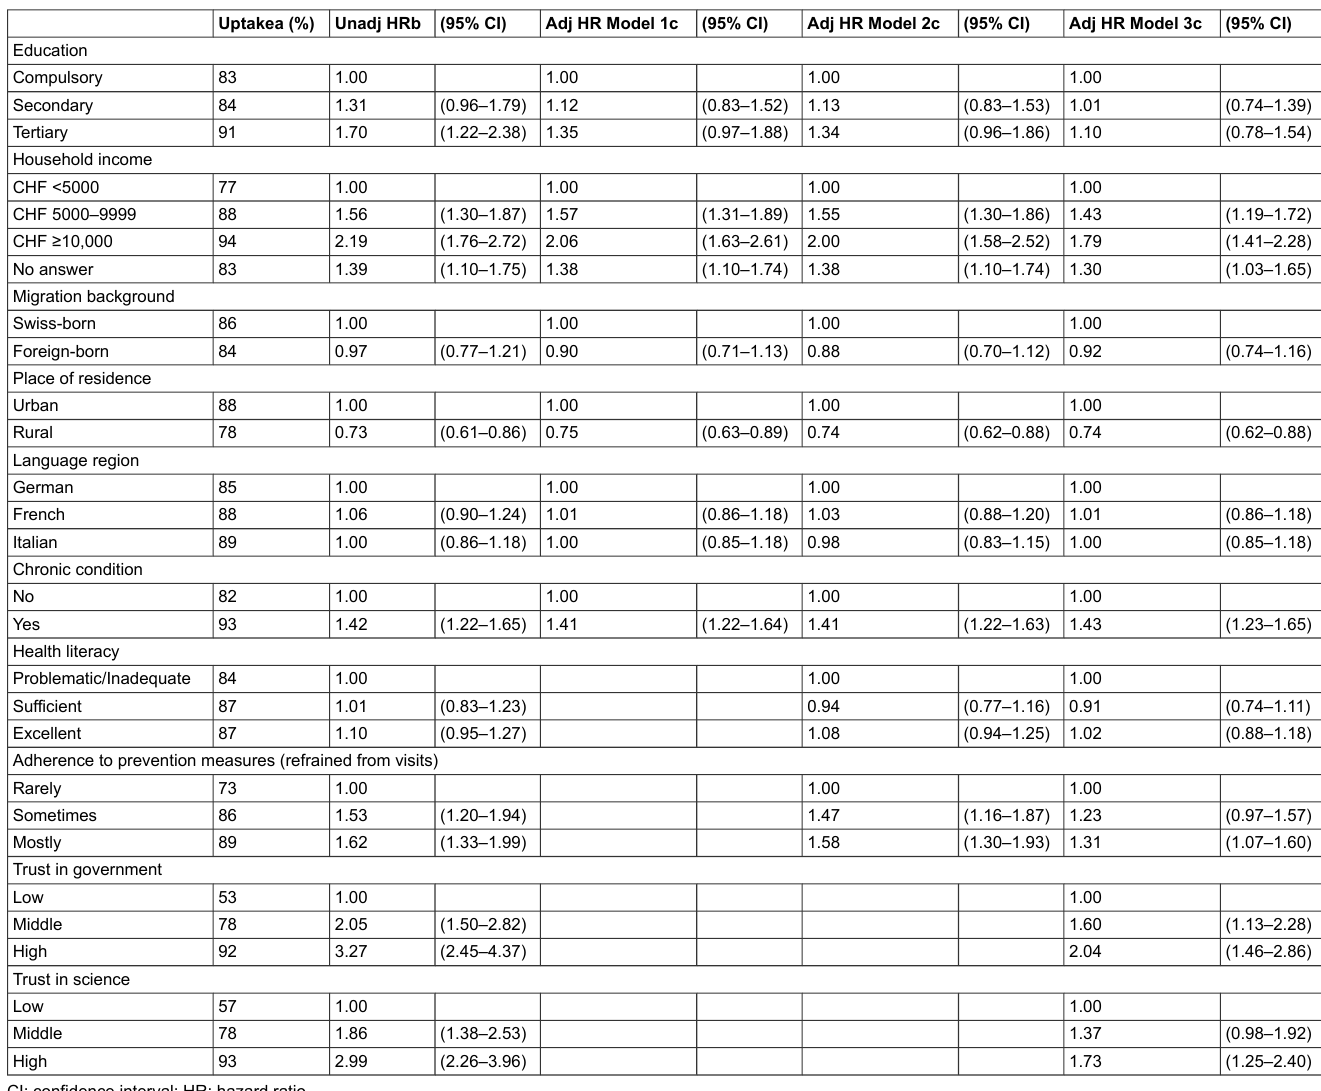
Table S2: Females – COVID-19 vaccine uptake and Cox proportional hazard ratios from univariable and multivariable analyses